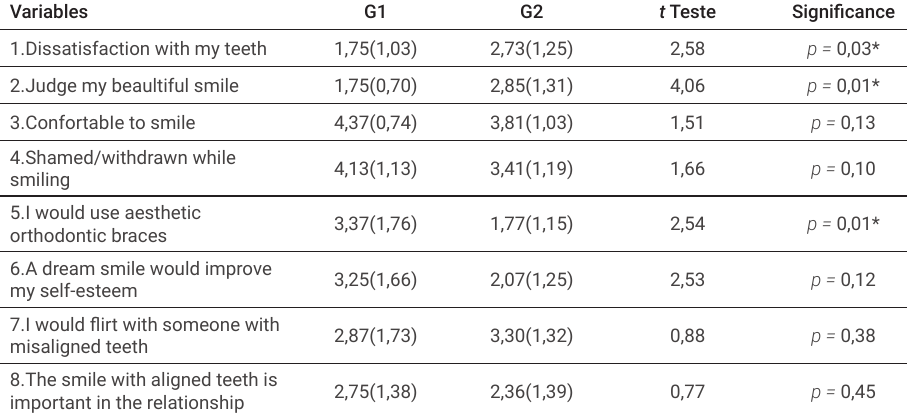
Table 4. Comparisons between G1 and G2 regarding male gender from March to December 2018 Variables G1 G2